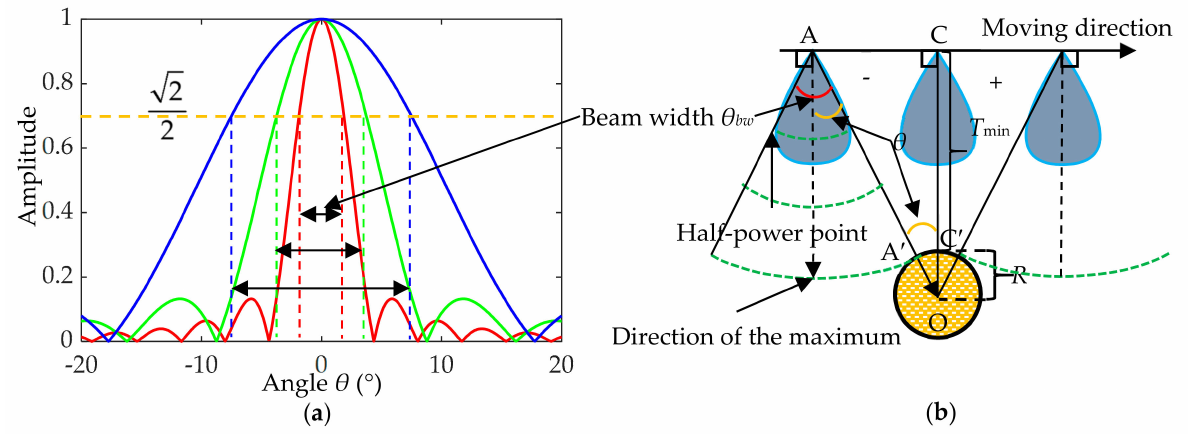
Figure 9. Influence of directivity pattern on pipeline imaging. ( a ) Examples of transducer directivity pattern; ( b ) energy variation of the sound pulse hitting the pipeline during the movement of the